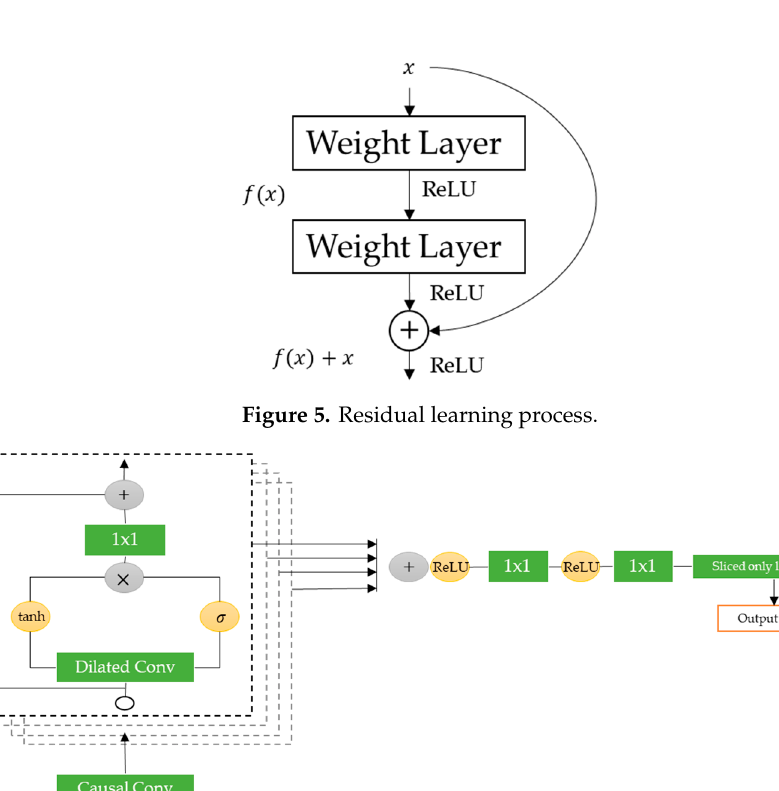
Figure 6. Overview of residual dilated convolutional block and gated activation function.